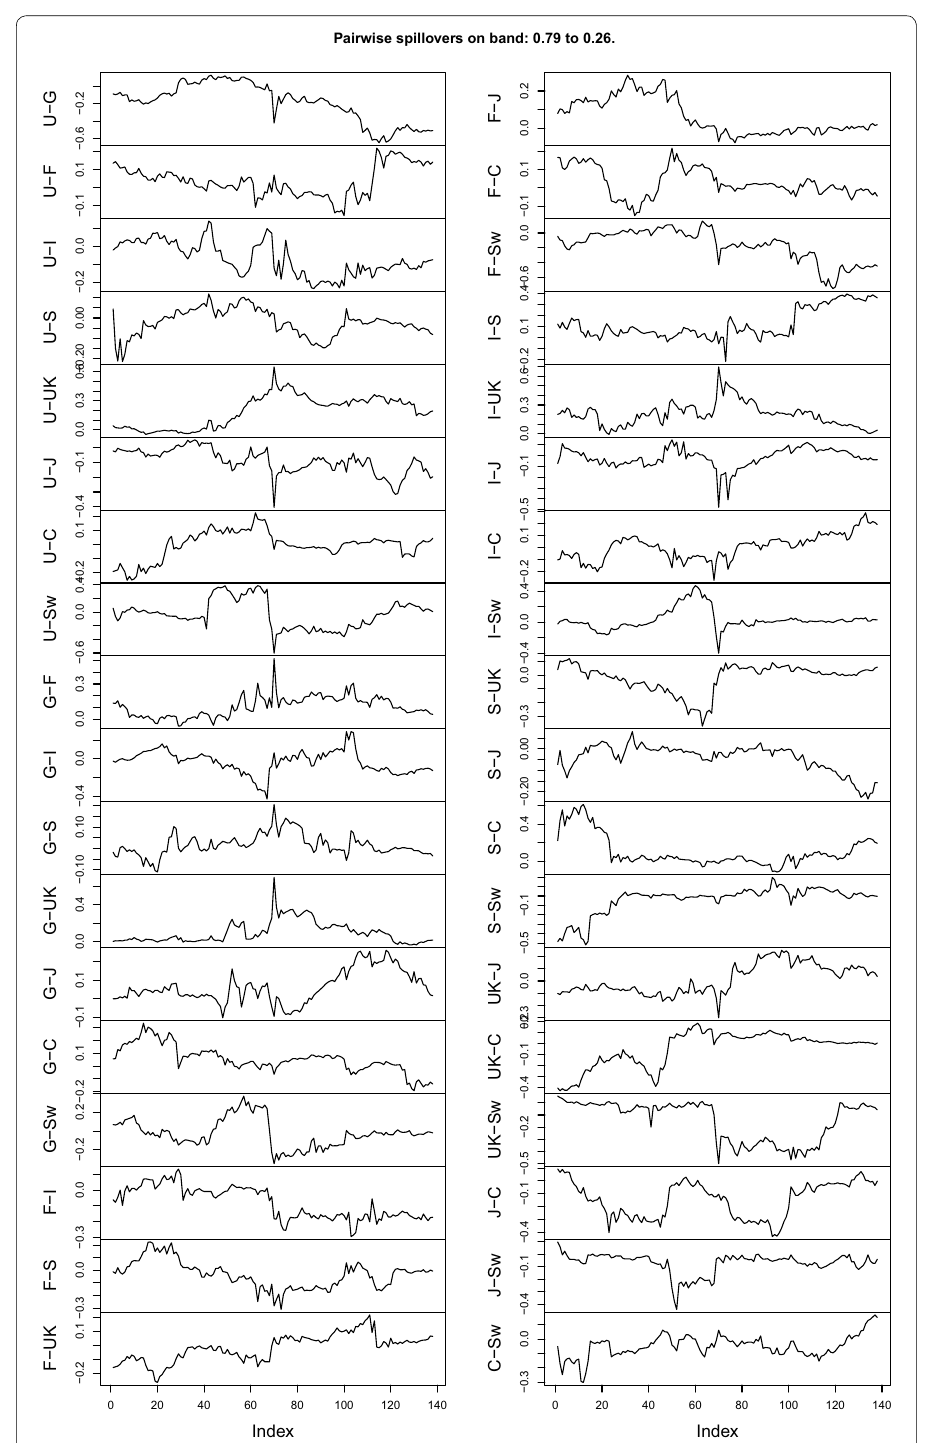
Fig. 15 10y12m—BK 4 to 12